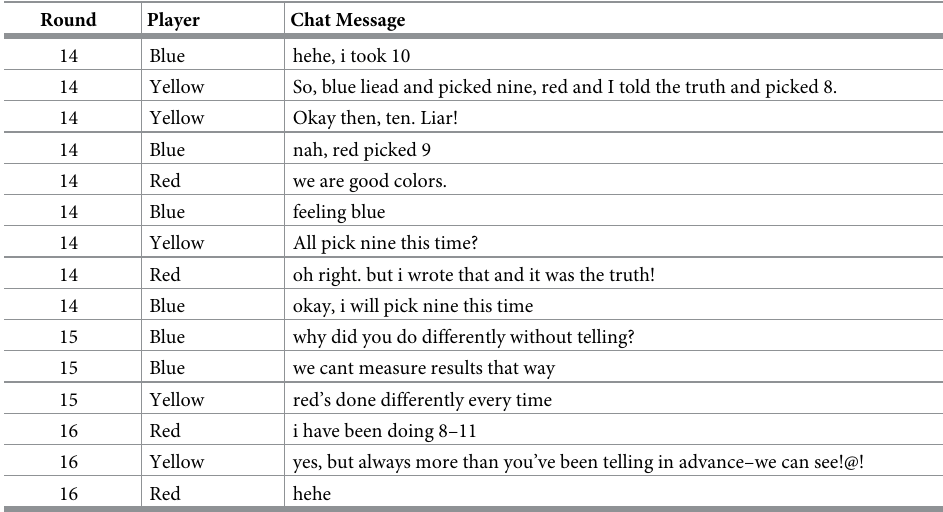
Table 7. Chat 2—Information increasing competition and conflict.